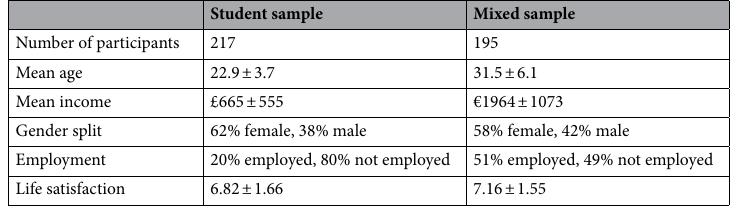
Table 3. Descriptives of study